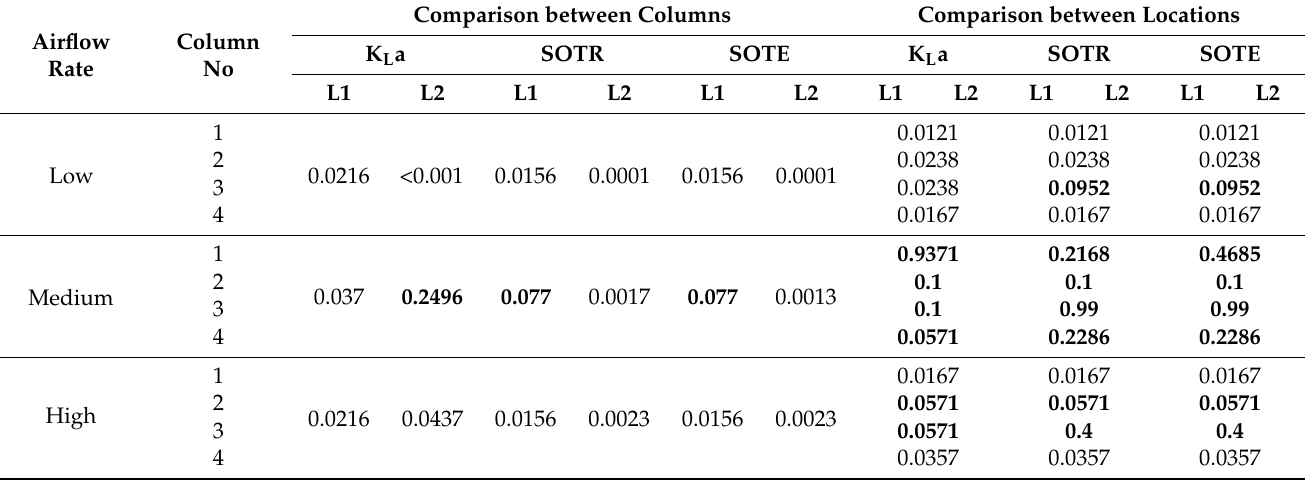
Table 3. Results of statistical comparison between columns for each airflow and statistical comparison between the two locations (atmospheric pressures) ( p